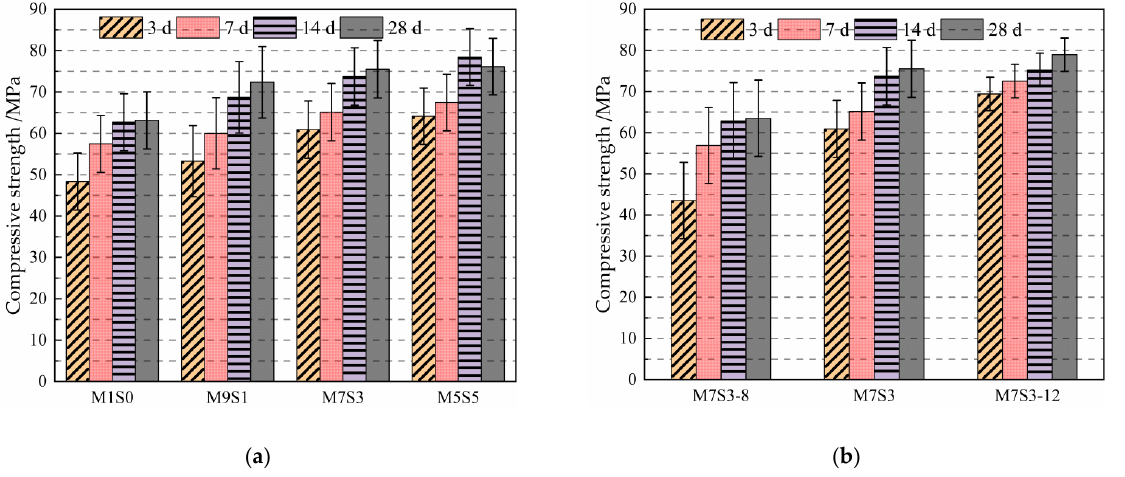
Figure 4. Compressive strengths of AAMS composite cementitious materials. ( a ) Different slag